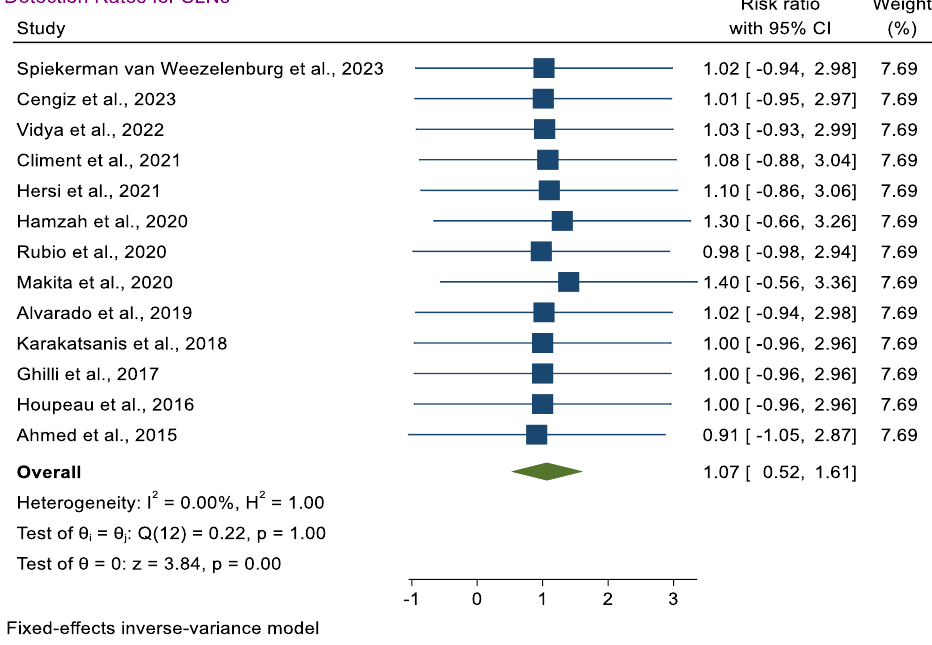
Fig. 3. The forest plot showed a sentinel lymph node detection